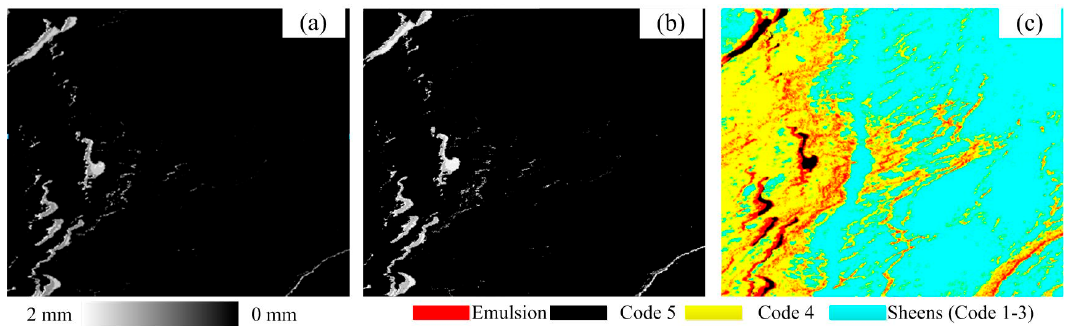
Figure 19. Photo ( a,b ): thickness results from USGS 2010. Picture ( c ): thickness results produced in this work.